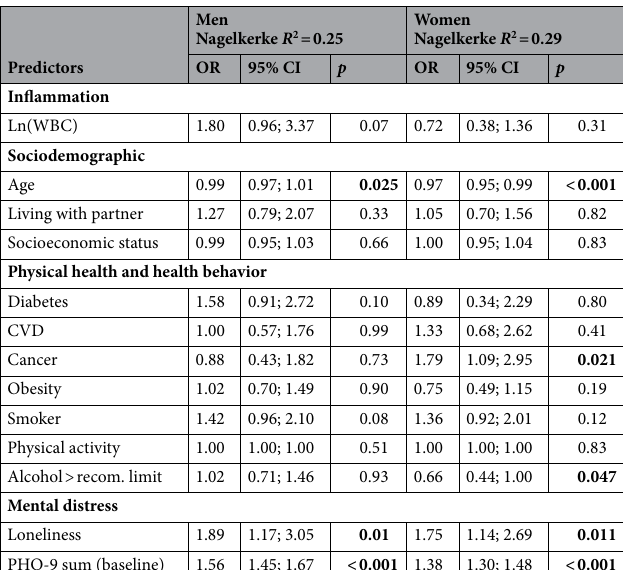
Table 5. Results of the logistic regression analysis: prediction of new onset of depression at follow-up (based on predictors measured at baseline 5 years earlier, including the natural logarithm of WBC), stratified by gender. Bold values indicate statistically significant predictors. CVD cardiovascular disease, PHQ‑9 patient health questionnaire-9, WBC white blood cell count.